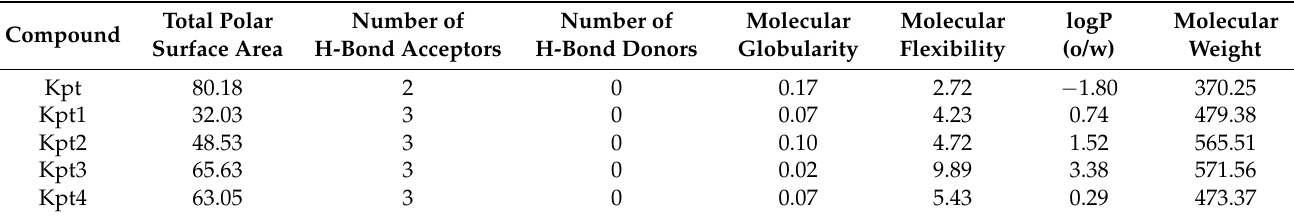
Table 2. Main physico-chemical descriptors of the investigated